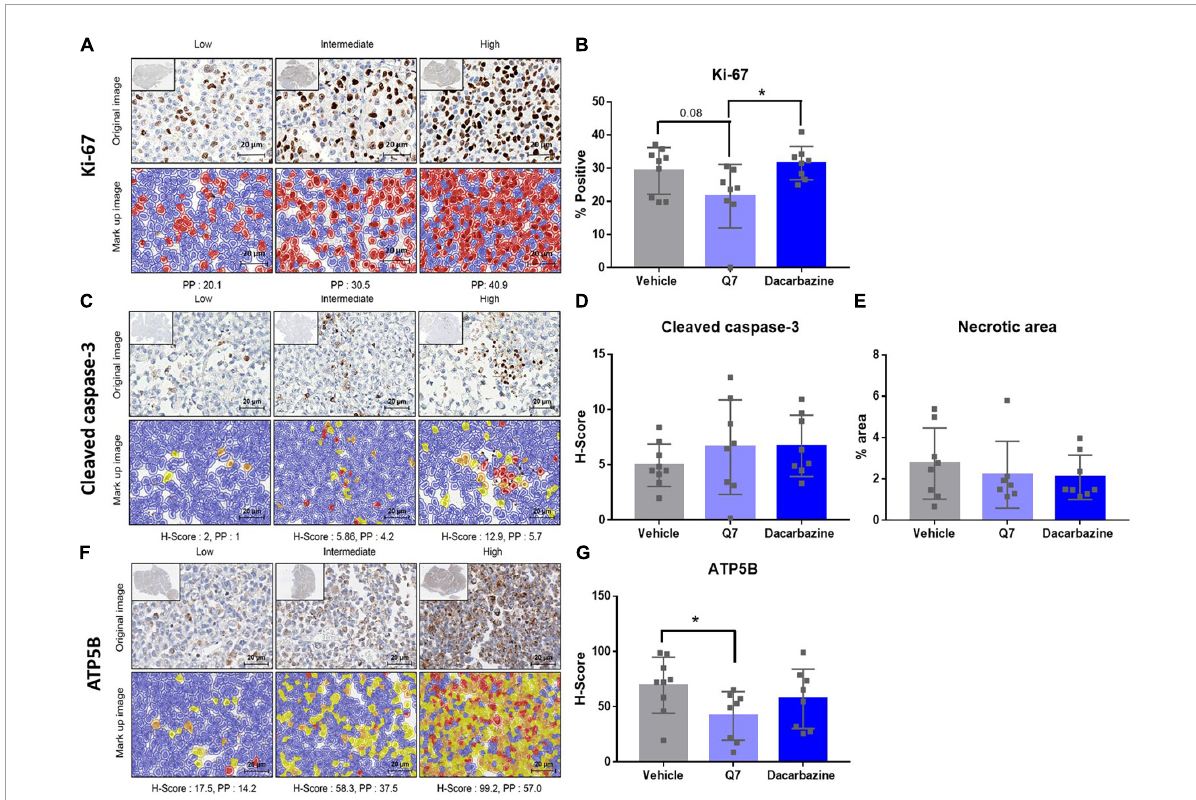
FIGURE6 1,4-dihydroxy quininib significantly reduces expression of ATP5B in a UM cell line-derived orthotopic xenograft model of metastatic uveal melanoma. (A–G) Representative digital pathology images and quantification graphs. (A) Representative sections, and associated marked up images, designated with a score of Low , Intermediate or High expression of Ki-67. Cells positive for Ki-67 staining are indicated in red and cells negative for Ki-67 staining are indicated in blue in the mark up images. (B) Treatment with 1,4-dihydroxy quininib (Q7) does not significantly alter the percentage of cells staining positive for Ki-67 vs. vehicle control ( p = 0.08). Treatment with 1,4-dihydroxy quininib significantly ( p = 0.02) alters the percentage of cells staining positive for Ki-67 vs. dacarbazine. There is no significant difference between vehicle and dacarbazine treated groups ( p = 0.45). (C) Representative sections, and associated mark up images, designated with a score of Low , Intermediate , or High expression of cleaved caspase-3 following digital pathology analysis. Blue indicates negative staining, yellow indicates H-Score of +1, orange indicates H-score of +2, red indicates H-Score of +3. (D) As assessed by H-Score, 1,4-dihydroxy quininib (Q7) and dacarbazine do not significantly alter cleaved-caspase 3 expression vs. vehicle ( p = 0.31 and p = 0.15, respectively). (E) The percentage of necrotic area was quantified using H&E tumour sections from each treatment group. There was no significant difference in the necrotic area between any treatment groups. (F) Representative sections, and associated mark up images, designated with a score of Low , Intermediate , or High expression of ATP5B. Blue indicates negative staining, yellow indicates H-Score of +1, orange indicates H-score of +2, red indicates H-Score of +3. (G) As assessed by H-Score, 1,4-dihydroxy quininib (Q7) significantly ( p = 0.03) reduces the expression of ATP5B vs. vehicle control. Dacarbazine does not significantly alter ATP5B expression vs. vehicle ( p = 0.35). Statistical analysis was performed using an unpaired two-tailed t -test. Error bars are mean ± SD. * p <